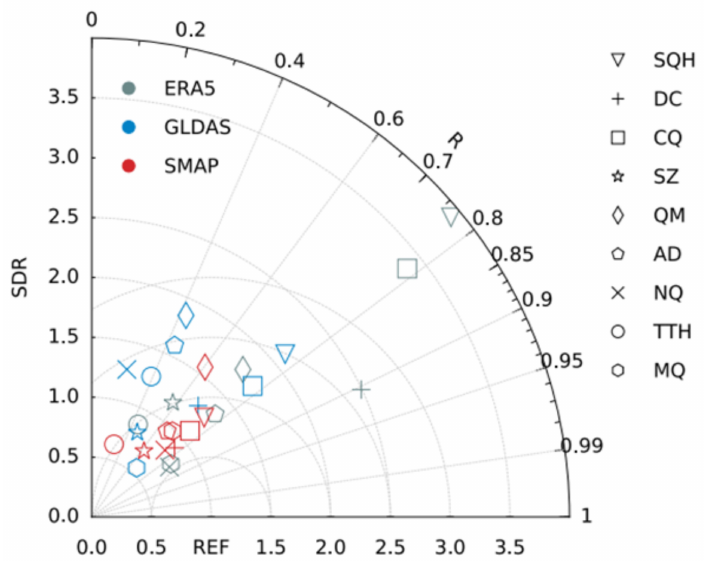
Figure 3. Taylor diagram of the Pearson correlation coefficient (R) and the ratio of the standard deviation (SDR) of product-derived soil moisture (SM) relative to In Situ measurements of SM; REF indicates In Situ SM